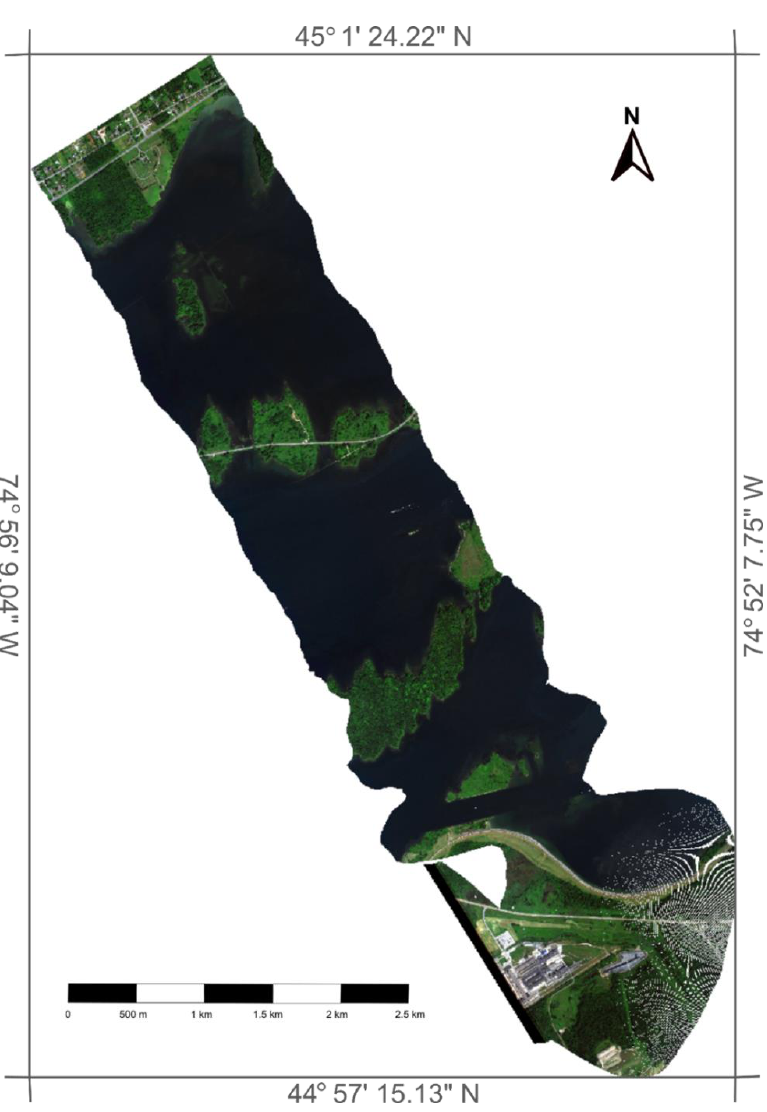
Figure 10. An example of imagery collected by a CASI-1500 onboard a manned aircraft acquiring imagery over the Long Sault Parkway, ON, Canada. Imagery was collected by a twin otter aircraft in partnership with the National Research Council of Canada. The NoData artefacts during the turn are portions of the ground over which no pixels are resolved in the geocorrection.